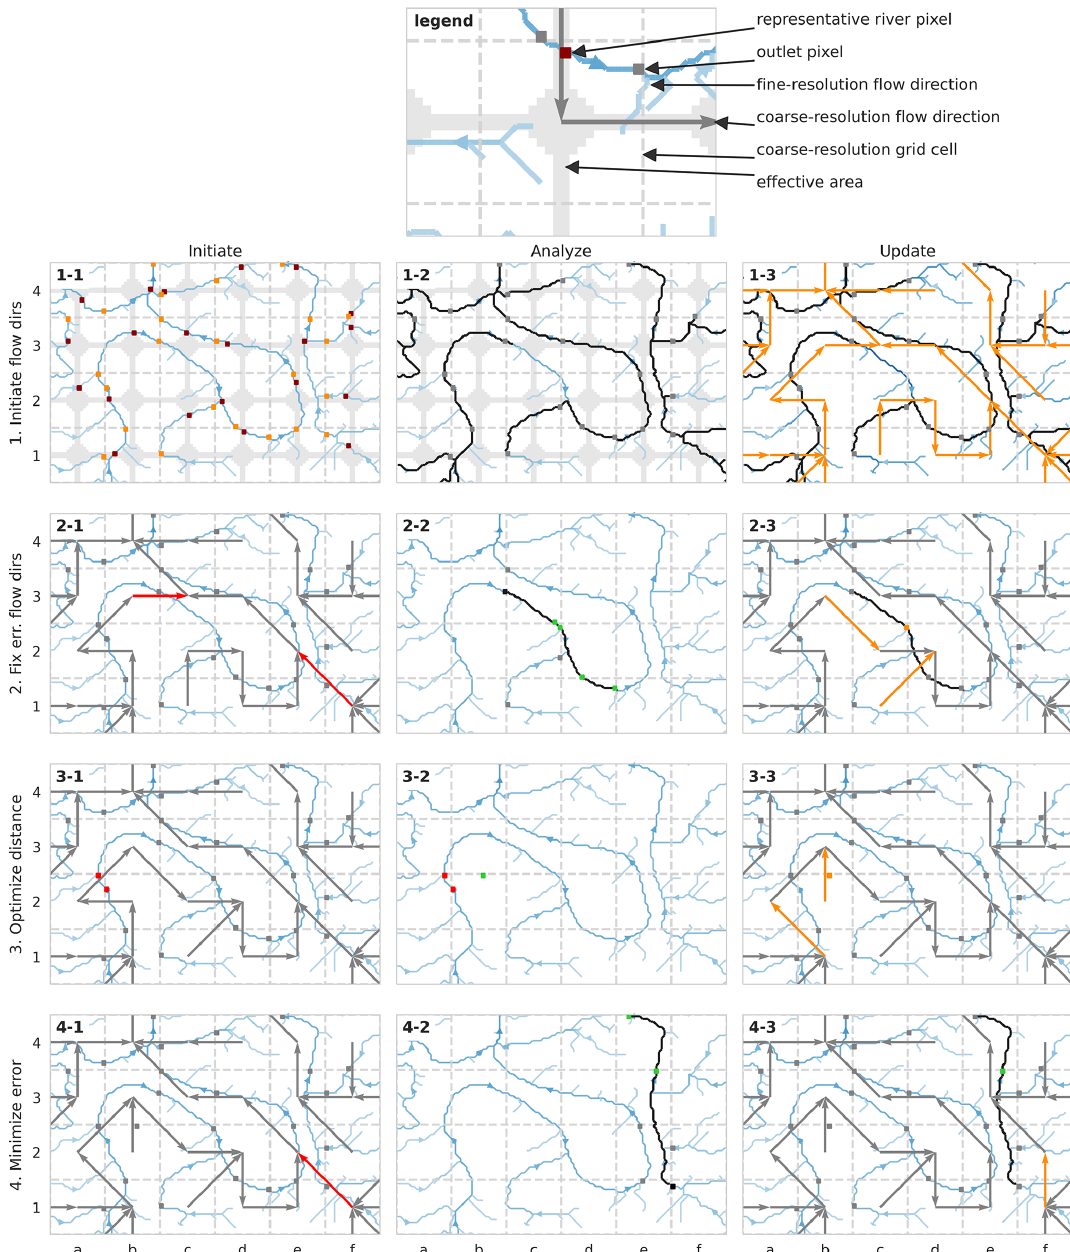
Figure 1. Illustration of the Iterative Hydrography Upscaling (IHU) method. Firstly, (1-1) the representative river pixel (dark red square) inside the effective area (shaded area) and the outlet pixel (orange square) are identified for each cell based on the upstream area; then (1-2) the fine-resolution flow path downstream of the outlet pixel (black lines) is traced to a neighboring cell to (1-3) set the initial upscaled flow direction (orange arrow). Secondly, (2-1) erroneous flow directions (red arrows) are identified and (2-2) analyzed in the context of the fine-resolution downstream flow-path (black line) with alternative outlet pixels (green squares) and tributary outlet pixels (grey squares) to (2-3) fix the flow directions by relocating outlet pixels (orange square and arrows). Thirdly, (3-1) outlet pixels with a short in-between distance are identified (red squares) and (3-2) alternative outlet pixels (green squares) with sufficient in-between distance are searched for, after which (3-3) outlet pixels are relocated and flow directions are updated accordingly (orange square and arrows). Fourthly, (4-1) remaining erroneous flow directions are identified (red arrows), and (4-2) from each neighboring cell the distance to a common downstream outlet pixel (green square) is measured to (4-3) update the flow directions (orange arrow) to the neighboring cell with the minimum distance in order to minimize upscaling